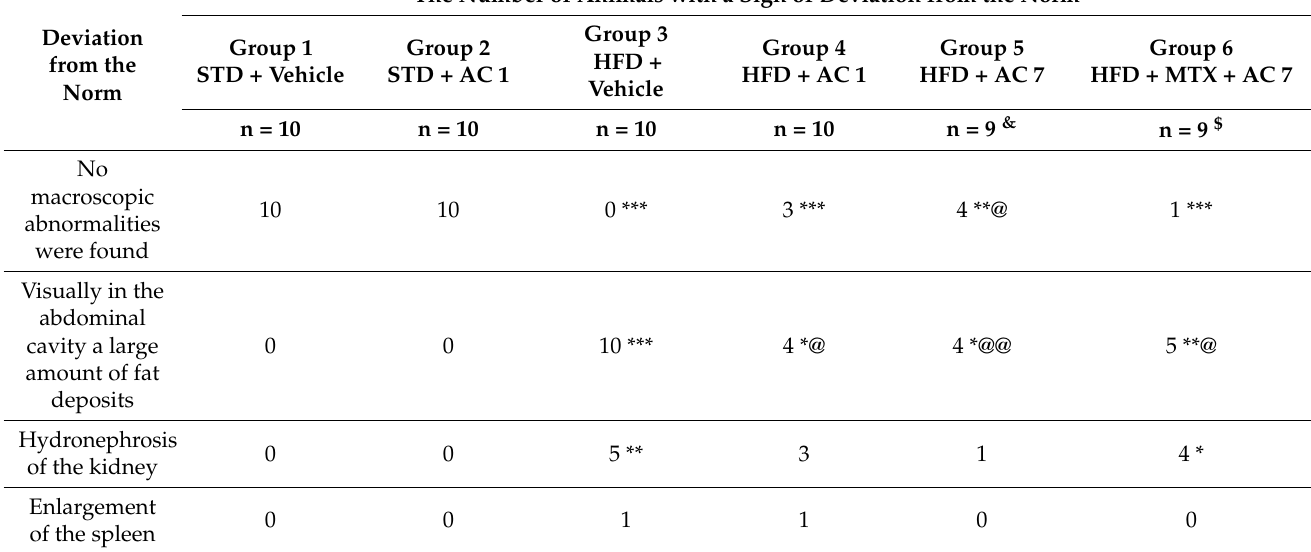
Table 9. Macroscopic abnormalities detected in animals during